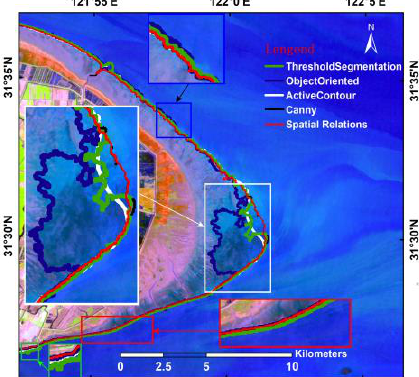
Figure 10. The waterline extraction methods are compared and analyzed on the reote sensing image of April 20,